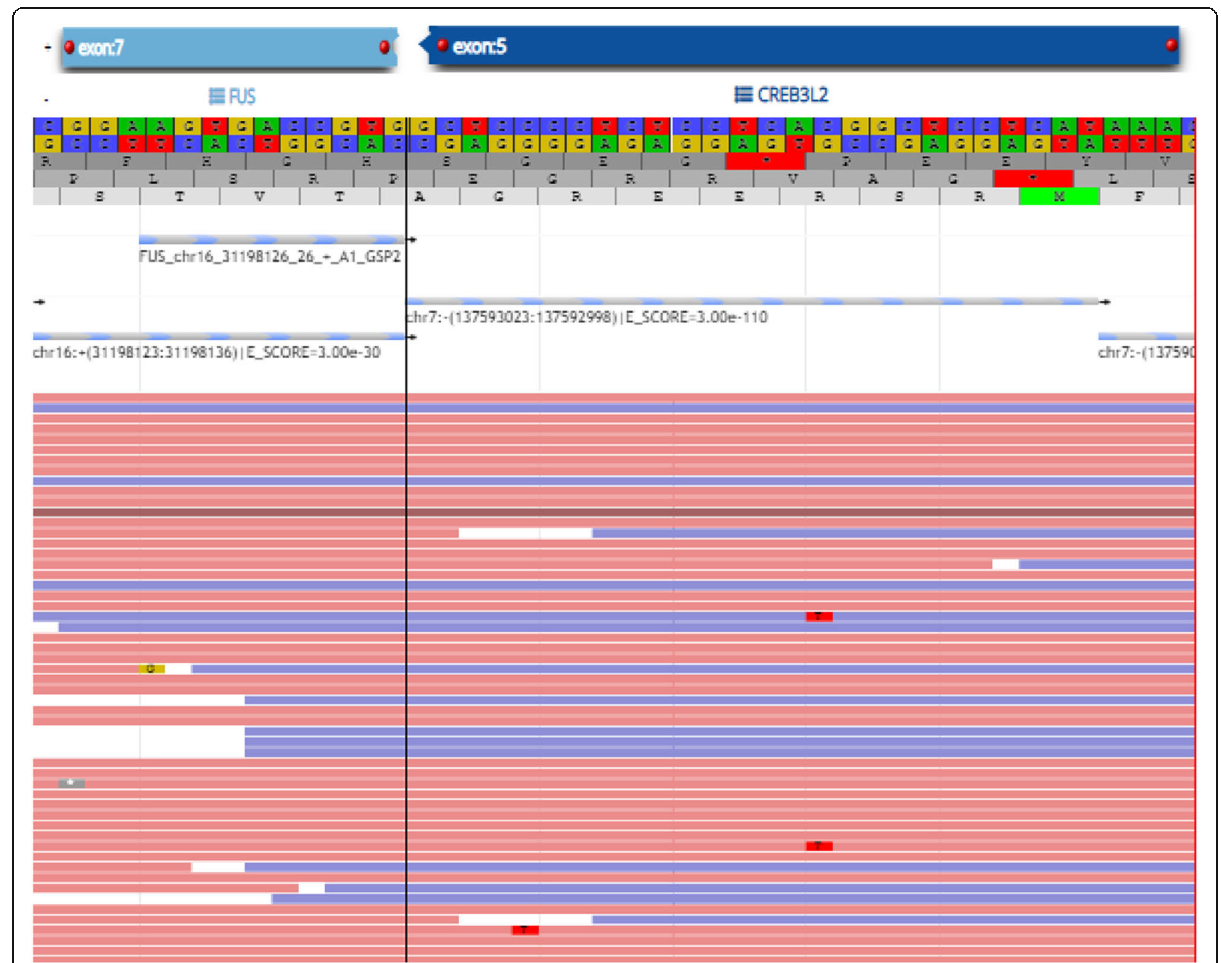
Fig. 5 Screenshot of the Multiplexed PCR using the Archer customize panel. The image showed the fusion between FUS exon 7 and CREB3L2 exon 5. The red and blue lines referred to the different reads supporting the fusion